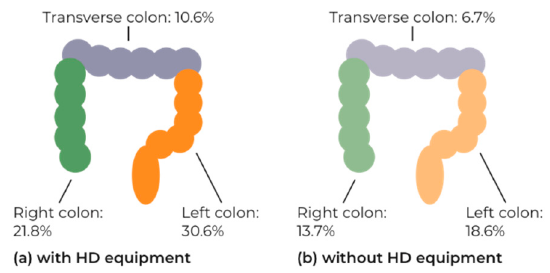
Figure 2. The proportion of procedures with a polyp detected by colon segment ( a ) with use of HD equipment and ( b ) without use of HD equipment. Includes procedures where both use of HD equipment and polyp detection by segment are known: right segment 2902 procedures; transverse 2909 procedures; left 2959 procedures.